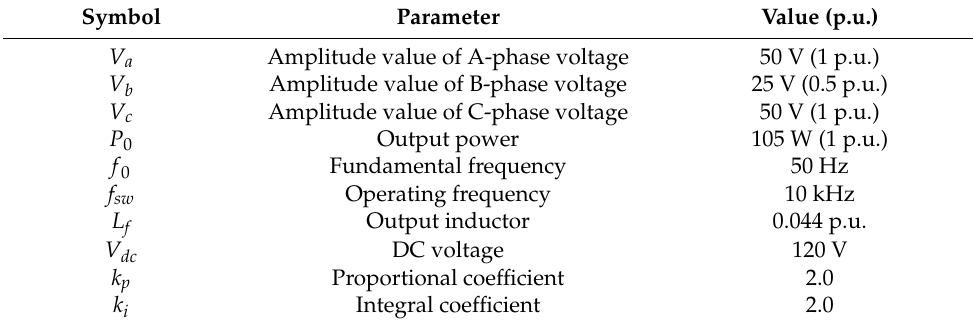
Table 4. Operating parameters of auxiliary module used in